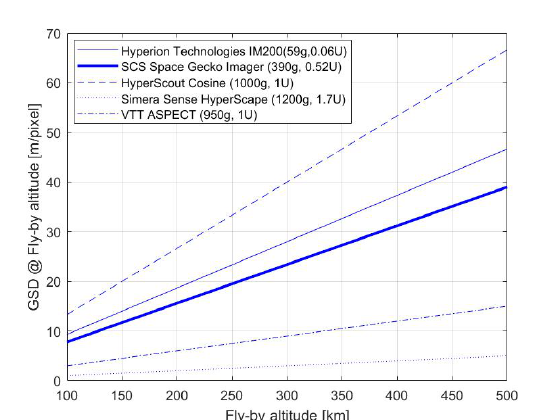
Figure 2. Ground Sampling Distance (GSD) as a function of the fly-by altitude, for off-the-shelf visible cameras, together with mass and volume